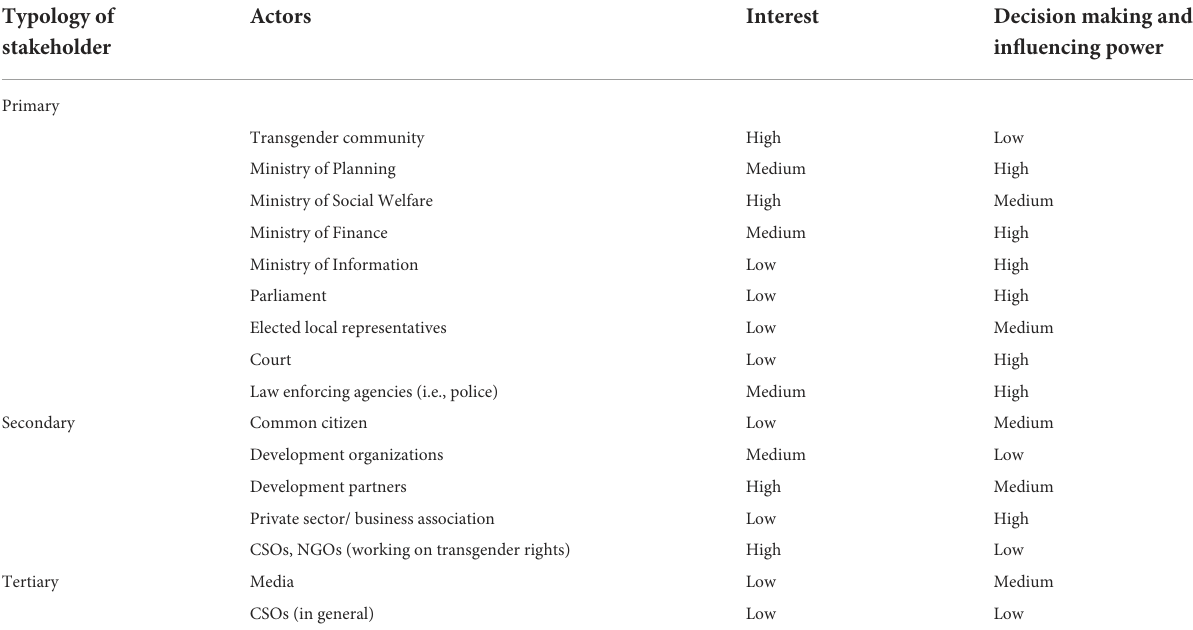
TABLE 1 Stakeholder mapping (developed by authors). Typology